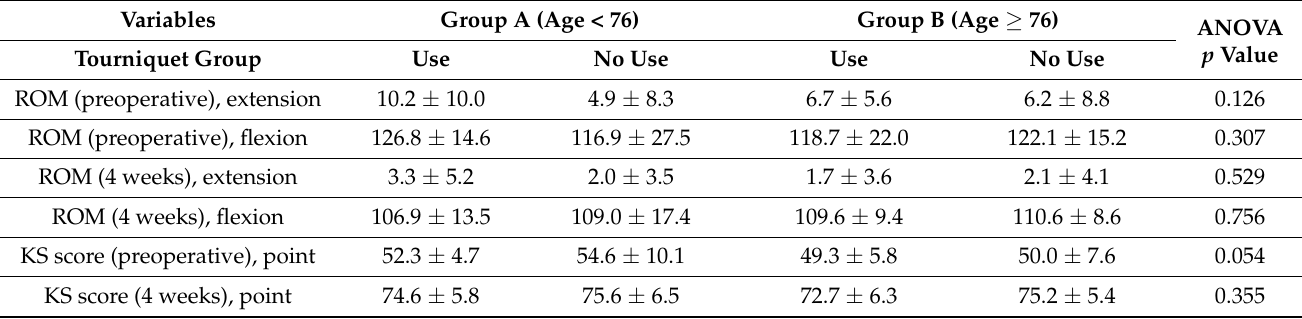
Table 3. Clinical evaluations.